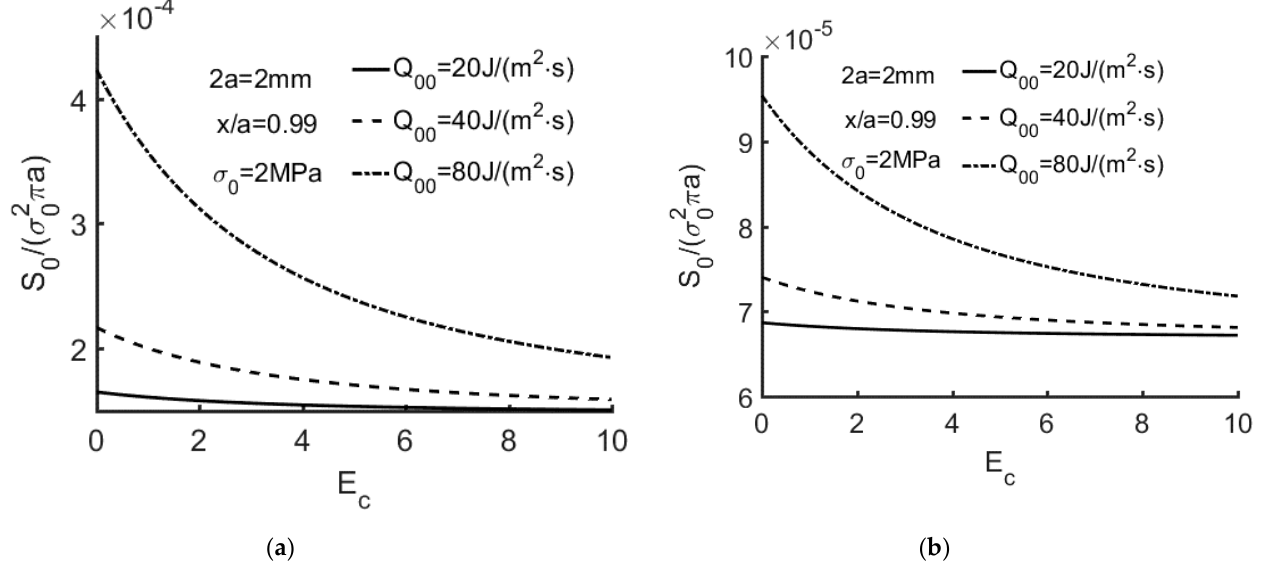
ε = 0.01. (2a = 2 mm, x/a = 0.99, σ 0 = 2 MPa). The ortho-